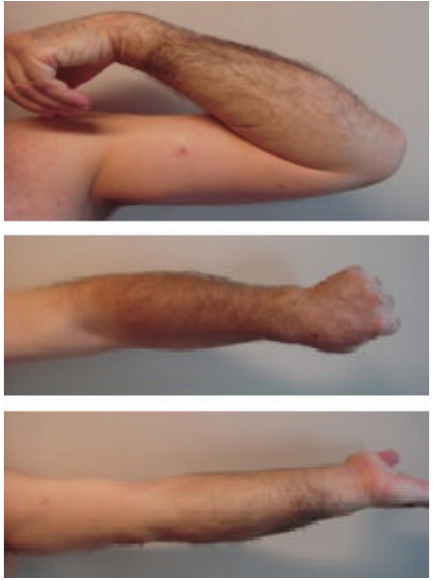
Figure 4: 6-month follow-up visit revealing the resultant range of